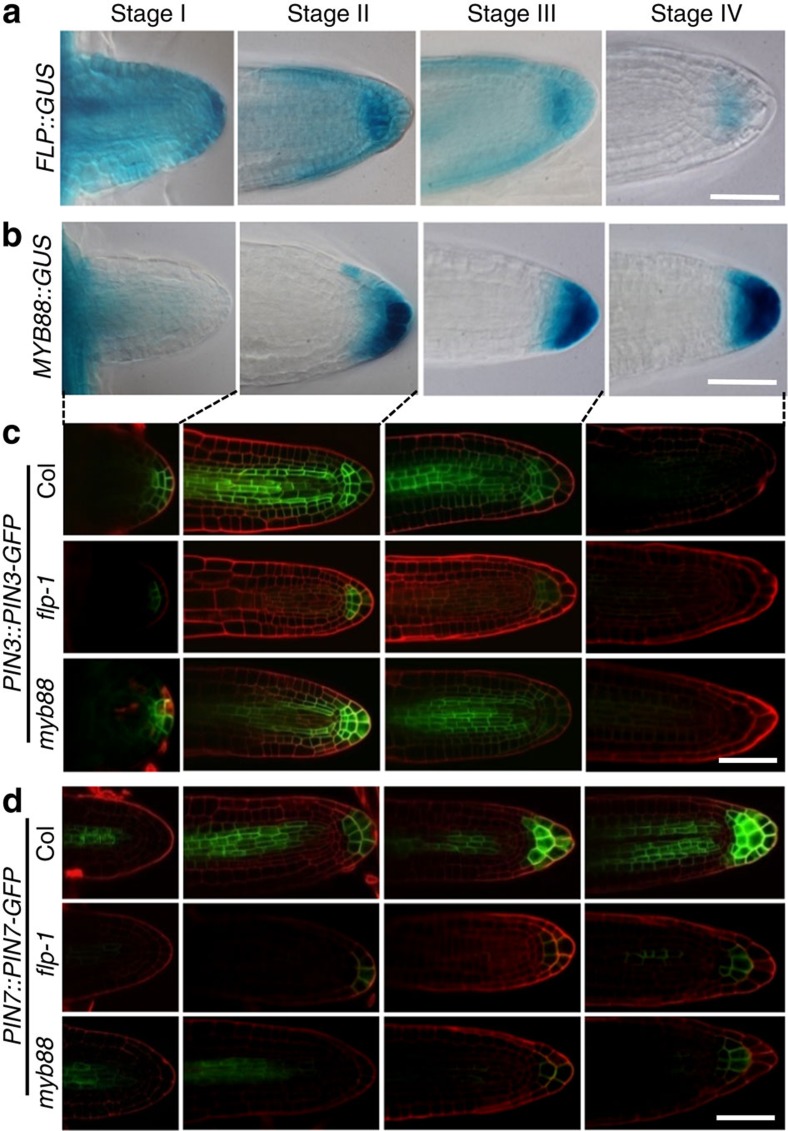
Association of FLP and MYB88 with PIN gene expression in lateral roots.(a) FLP::GUS is widely expressed in emerging lateral roots at Stage I and this expression is reduced as lateral roots elongate, but remains high in Stage II columella cells. Then, FLP::GUS expression is gradually reduced from Stages III to IV. (b) MYB88::GUS expression was barely detected in initiating lateral roots (Stage l), but signal was found in columella cells in Stage II lateral roots. During Stage III, the GUS expression domain expanded into more columella cells. The signal then became more intense in columella cells in the apex during stages III and IV. (c) PIN3::PIN3-GFP is expressed in emerging wild-type lateral roots and then declines from Stage III onwards. PIN3-GFP fluorescence is weak in flp-1 lateral roots at all the same developmental stages. By contrast, the PIN3-GFP expression pattern appears to be unaffected in myb88 lateral roots. (d) PIN7::PIN7-GFP expression partially overlaps with that of PIN3::PIN3-GFP in lateral roots at Stage II, but later becomes enhanced. PIN7-GFP fluorescence intensity is reduced in flp-1 and myb88 lateral roots. Scale bar, 50 μm.